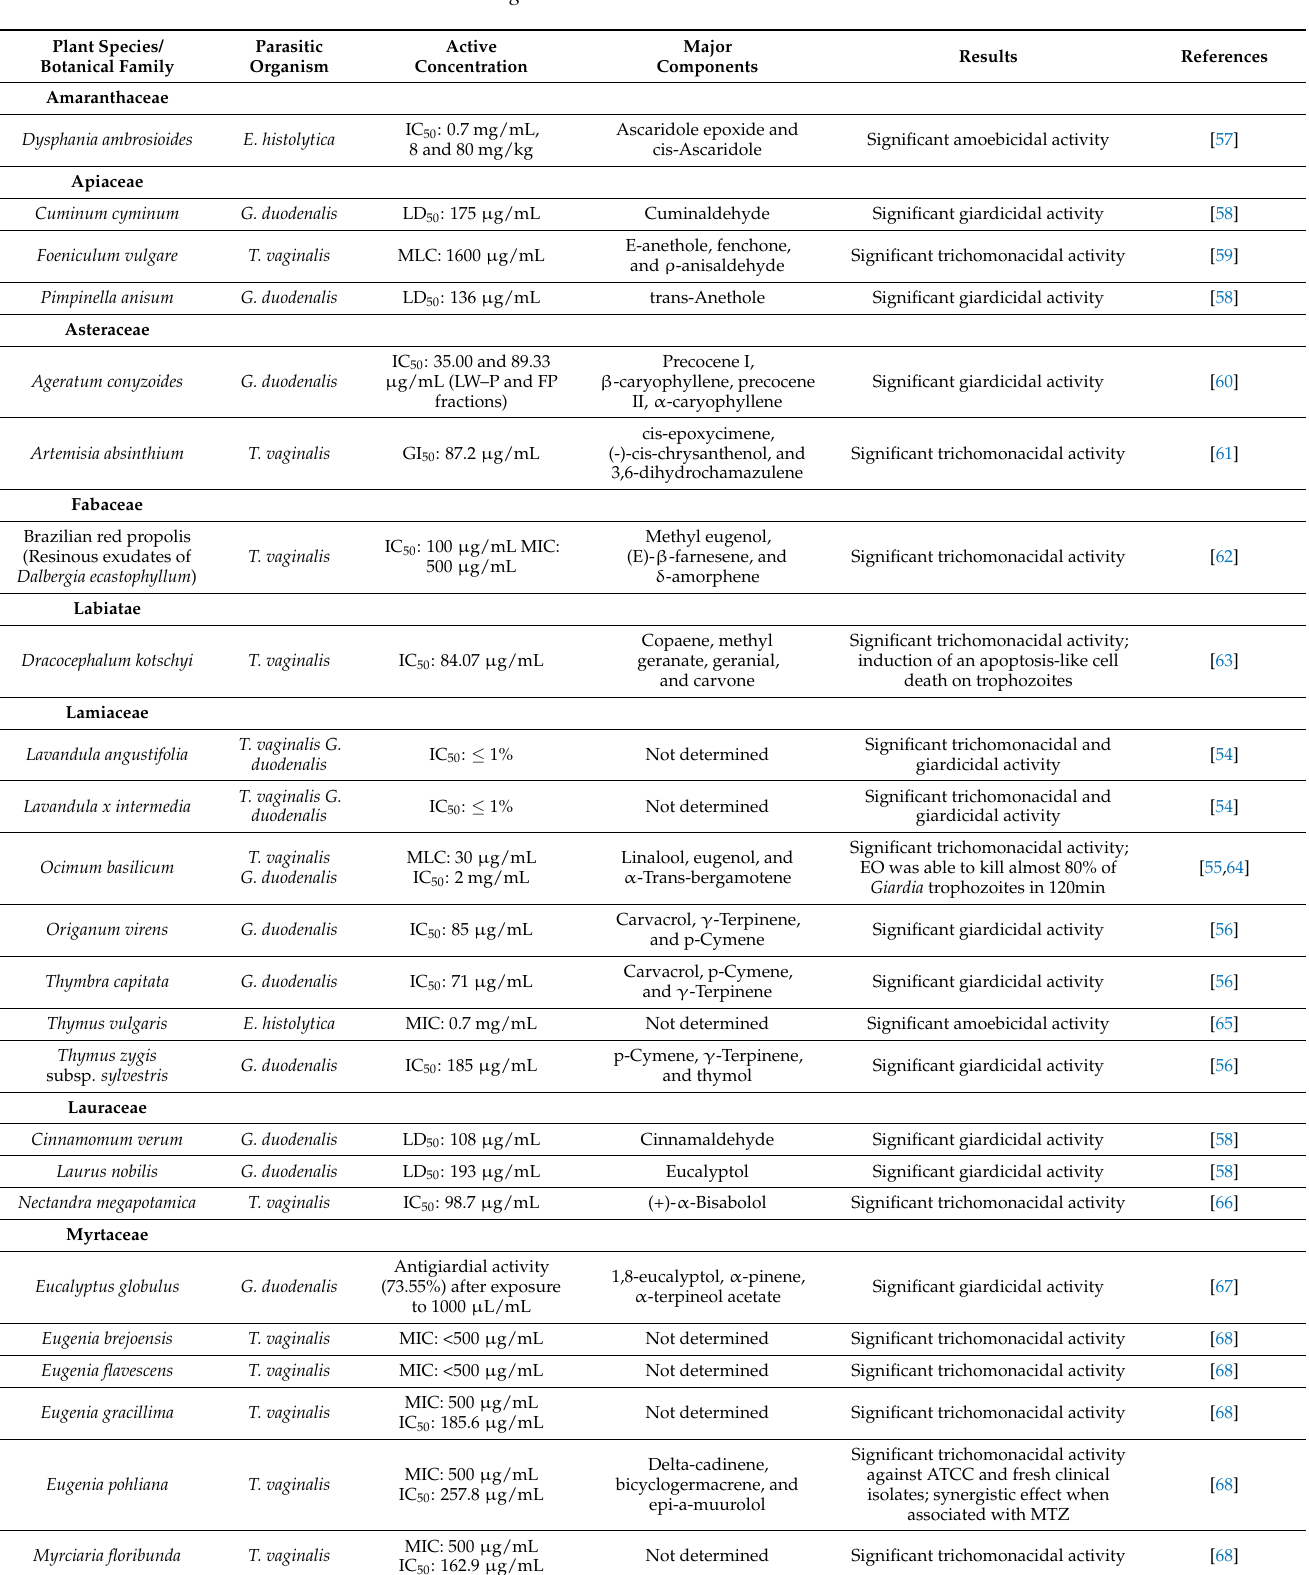
Table 1. Essential oils from plant species with activity against Giardia duodenalis , Entamoeba histolytica , and Trichomonas vaginalis